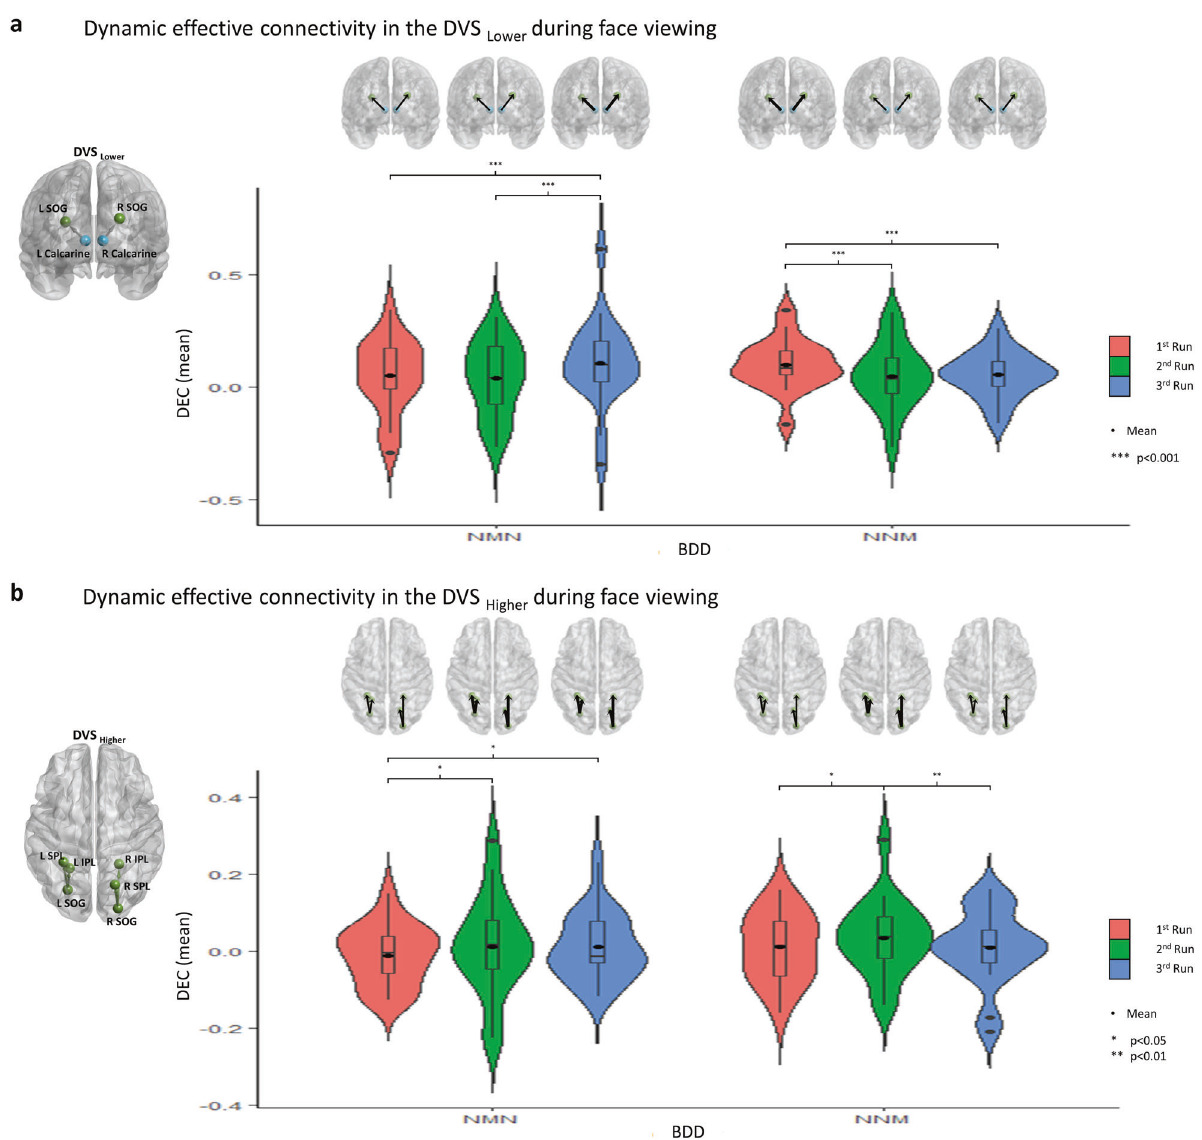
Fig. 3 Brain Connectivity in the Dorsal Visual Stream (DVS) in Body Dysmorphic Disorder (BDD) Participants. Means of dynamic effective connectivity for the ( a ) DVS Lower and ( b ) DVS Higher in the BDD group with the NMN and NNM orders. Brain graphs are presented above violin plots in which the thickness of the arrows indicates the relative changes of the mean dynamic effective connectivity values across runs. The participants randomized to the NMN order received natural viewing (N), modulated viewing (M), and then natural viewing (N) as the 1st, 2nd, and 3rd runs; those randomized to the NNM order received natural viewing (N), a second natural viewing (N), and then modulated viewing (M), as the 1st, 2nd, and 3rd runs. The p -values were Bonferroni